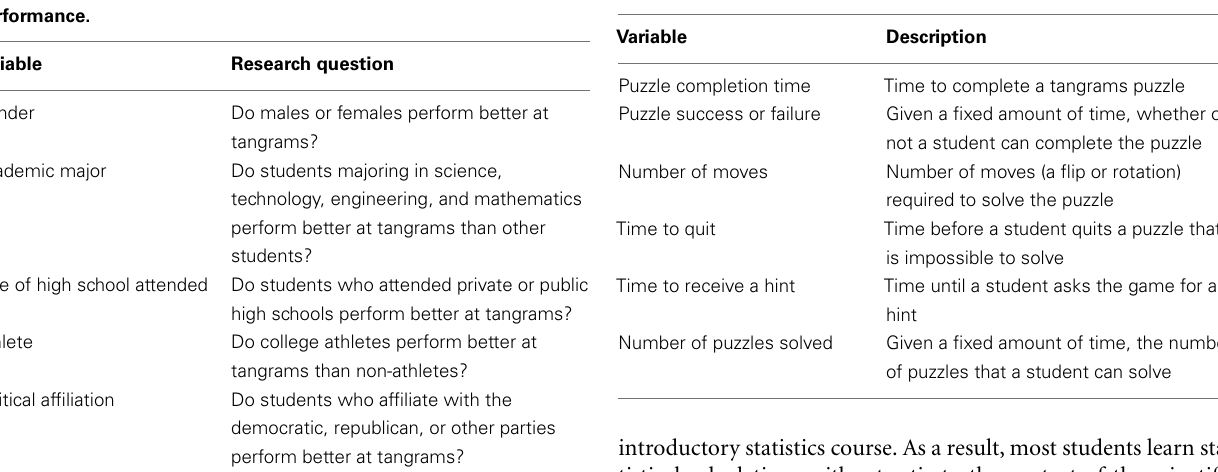
Table 5 | Candidate dependent